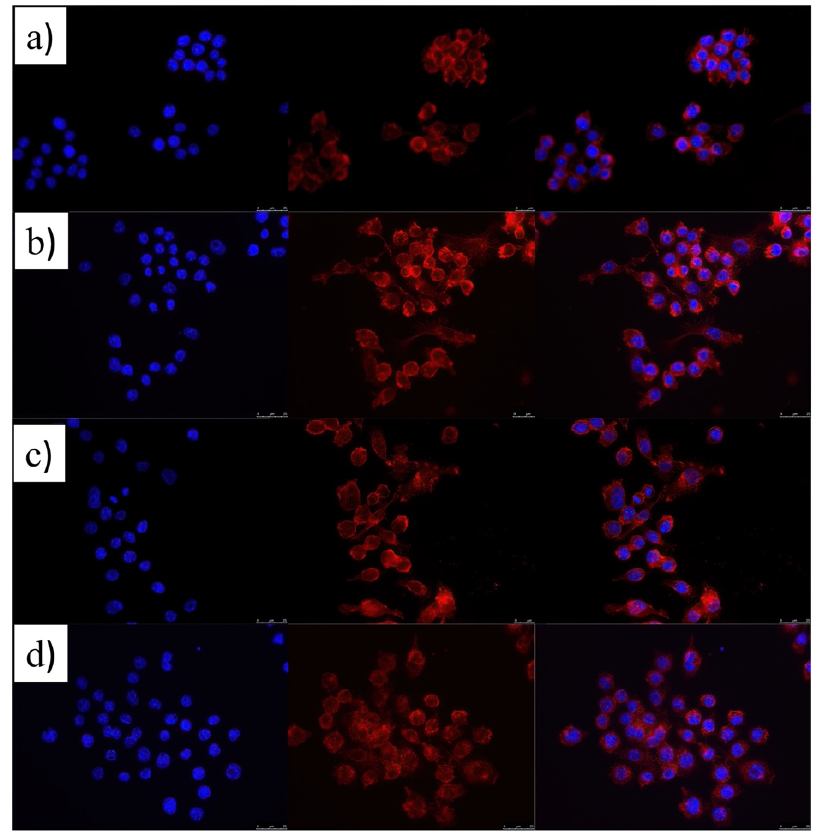
Figure 4. Morphology of RAW 264.7 macrophages: ( a ) non-activated; ( b ) activated with 100 ng/mL LPS; ( c ) after administration of 5 × 10 10 NPs/mL of ATOR-PLGA NPs (20 mM drug); ( d ) after administration of 5 × 10 10 NPs/mL ATOR-PLGA/miRNA NPs (20 mM drug–100 nM miRNA). From left to right: DAPI channel; BODIPY-Alexa Fluor 647 channel; merge image. Scale is 25 mm.